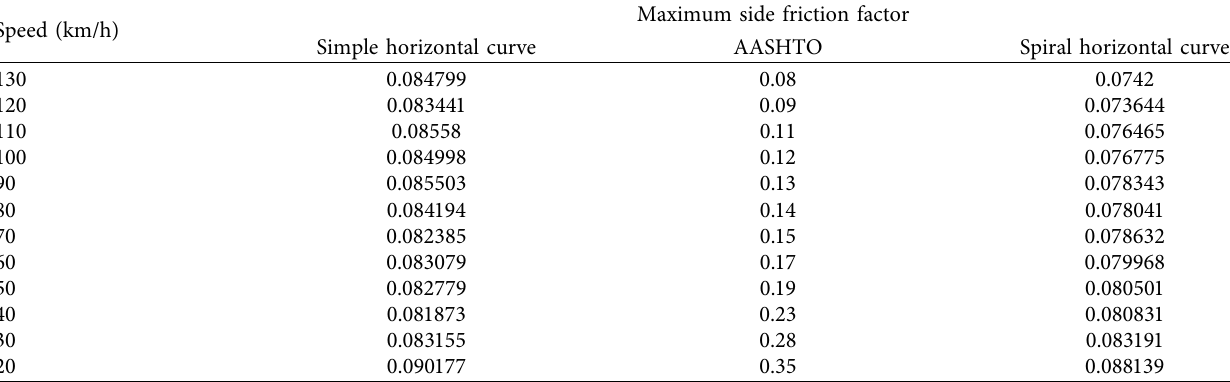
Table 15: Comparison of the maximum side friction factor between simple and spiral horizontal curves and AASHTO recommended values for sedan at a radius of